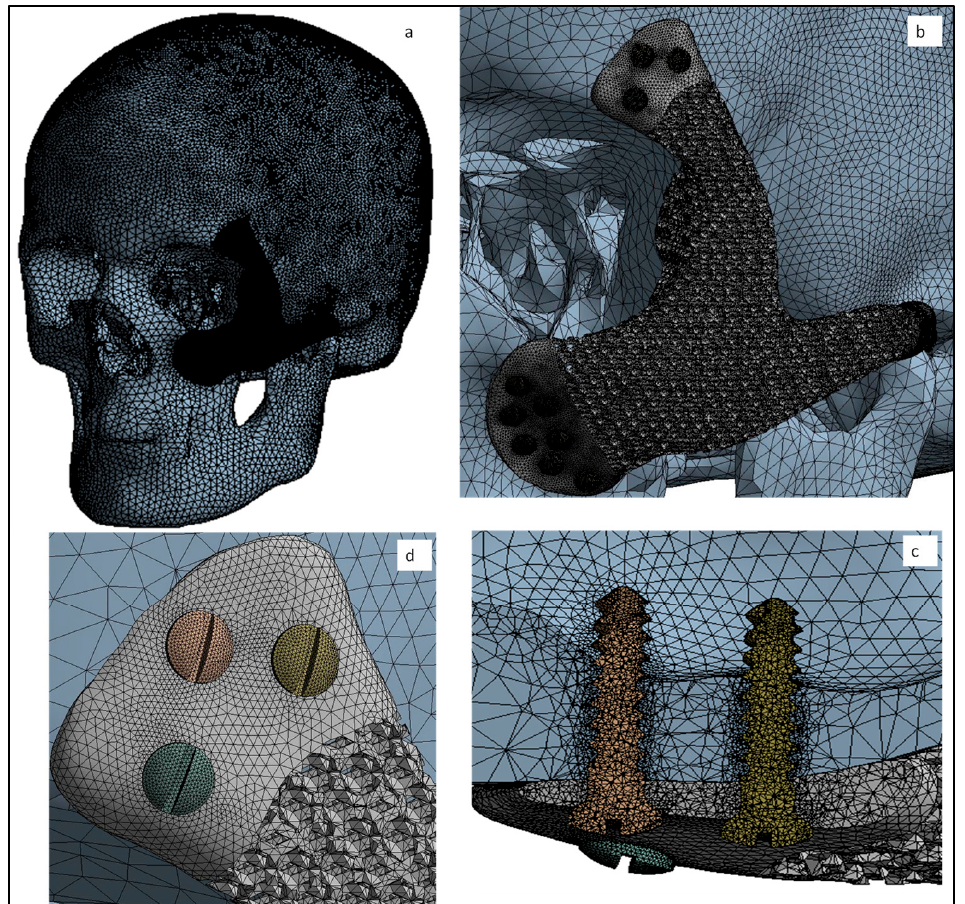
Figure 11. ( a , b ) Global view of finite element mesh and a more refined mesh on the ( c , d ) fixa- tion